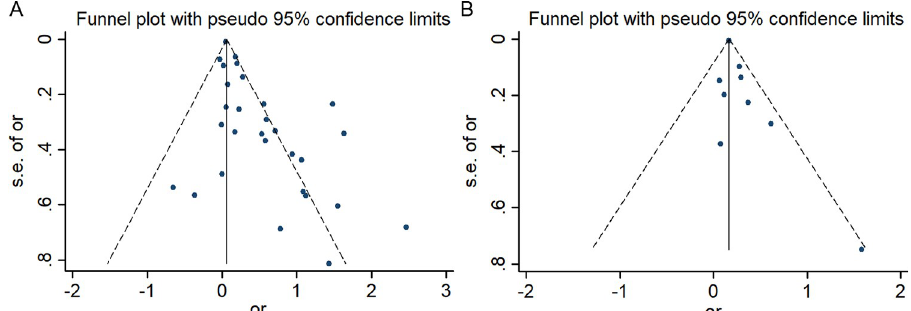
Fig 3. Funnel plot: A: diabetic nephropathy predicting incident depression. B: depression predicting incident diabetic nephropathy.